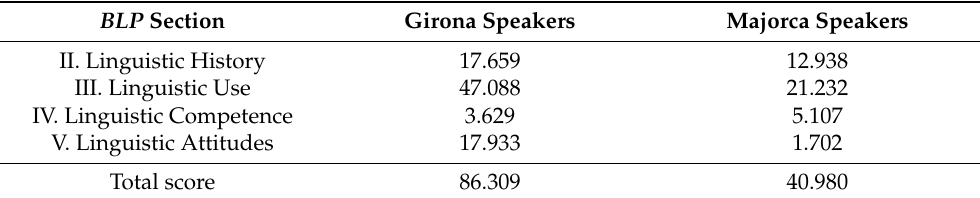
Table 1. Mean scores in the BLP questionnaire for Girona speakers and Majorcan speakers. Results from each section and final scores are